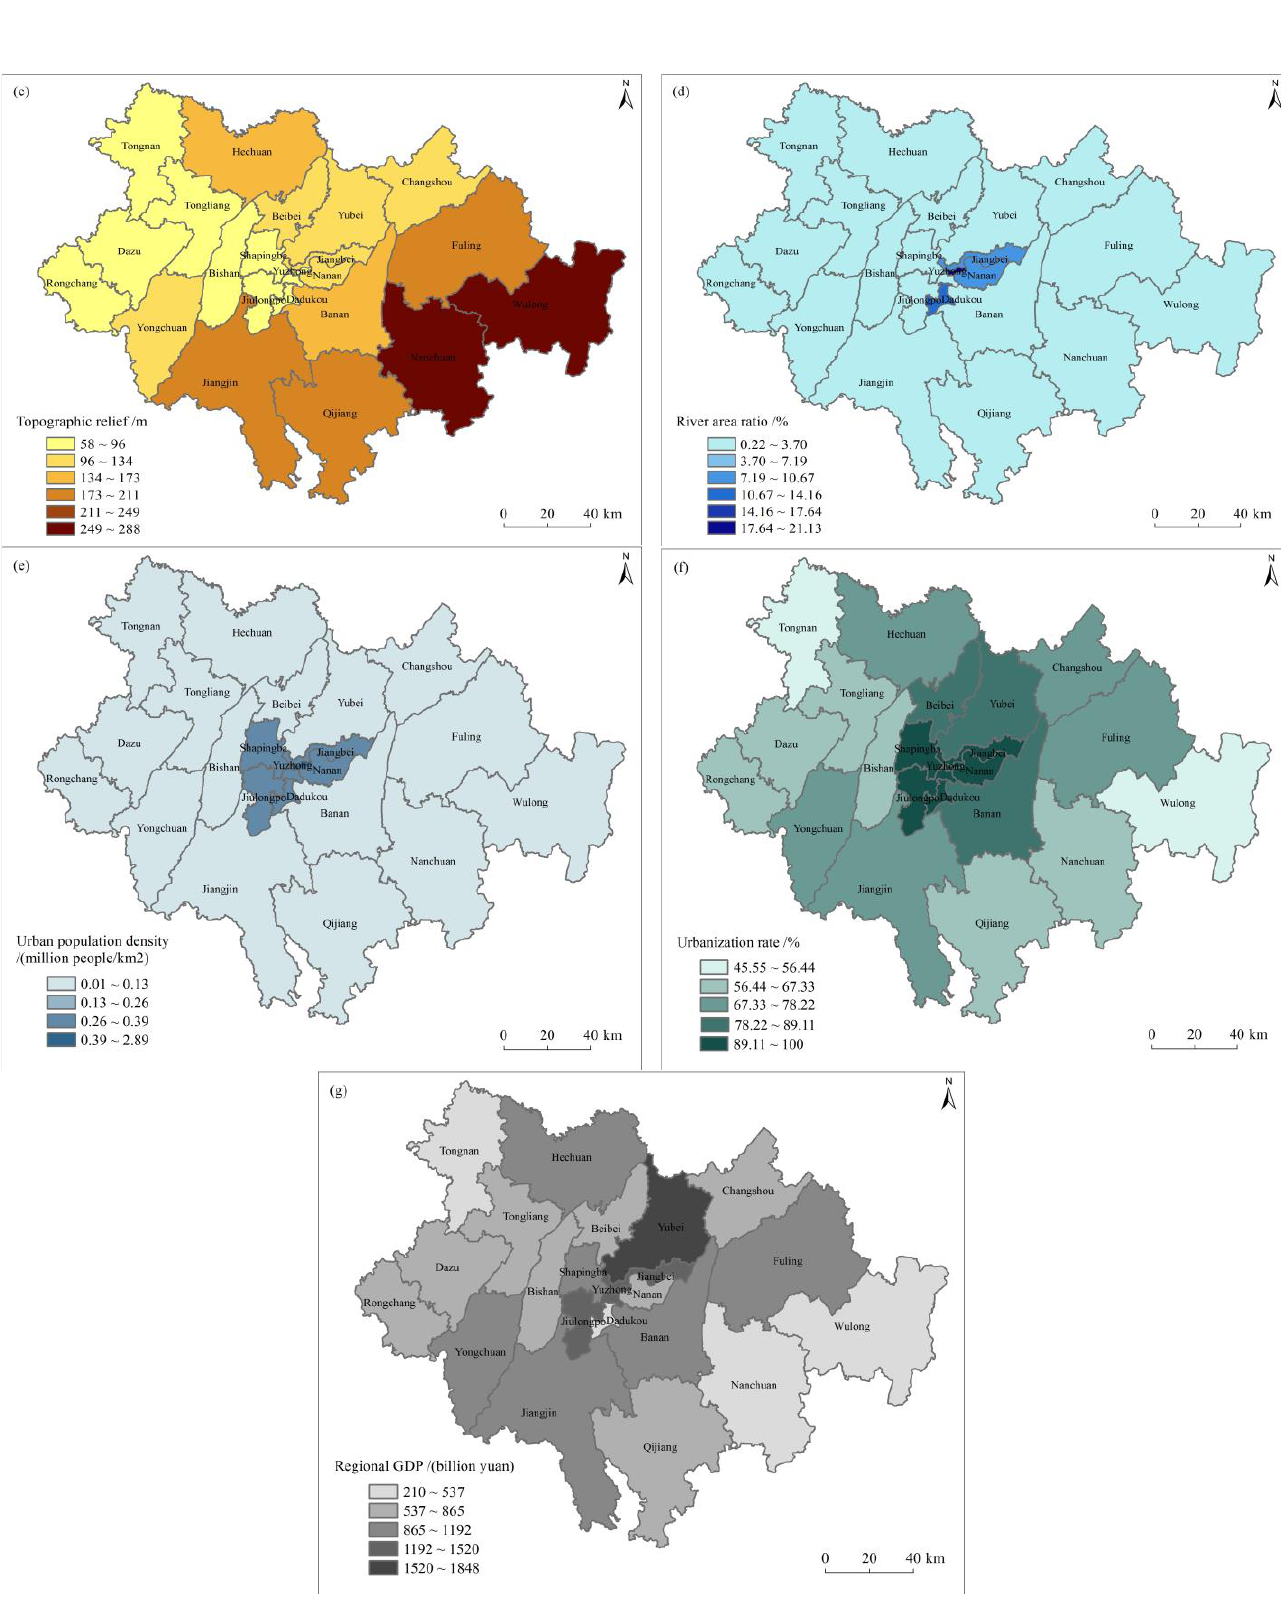
Figure 3 . Spatial distribution of 7 driving factors for partition. Figure 3. Spatial distribution of 7 driving factors for